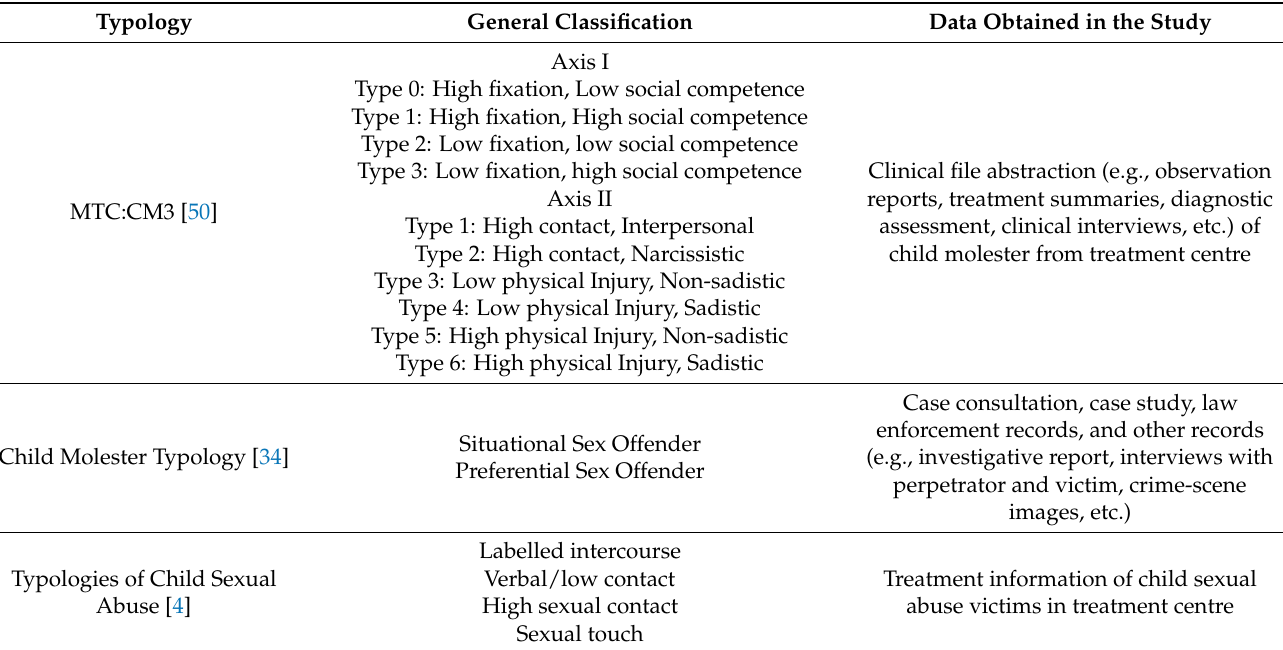
Table 1. Summary of child sexual abusers’ typologies and source of data